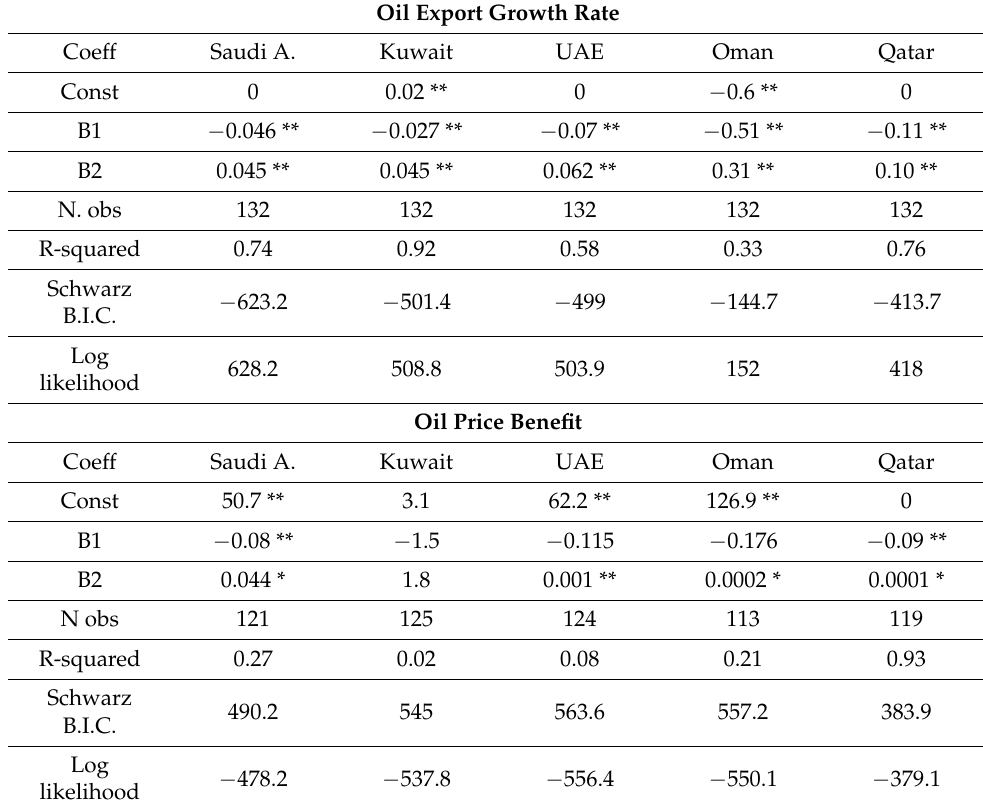
Table 4. Estimation